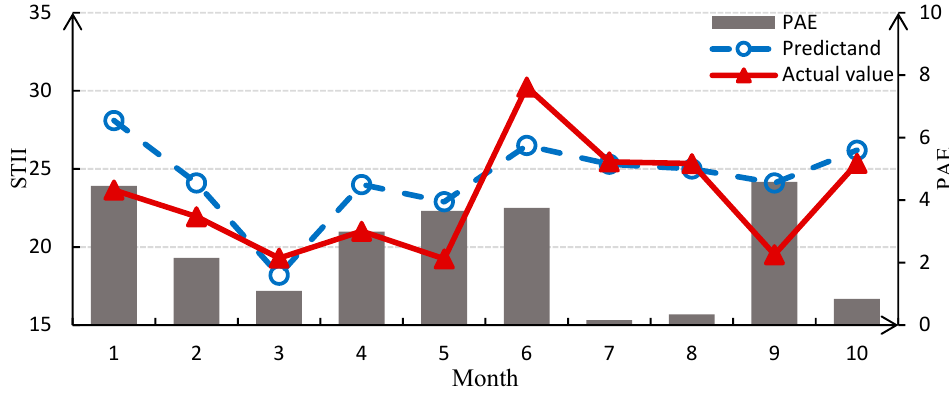
Figure 5. Monthly prediction of STII in the test period.